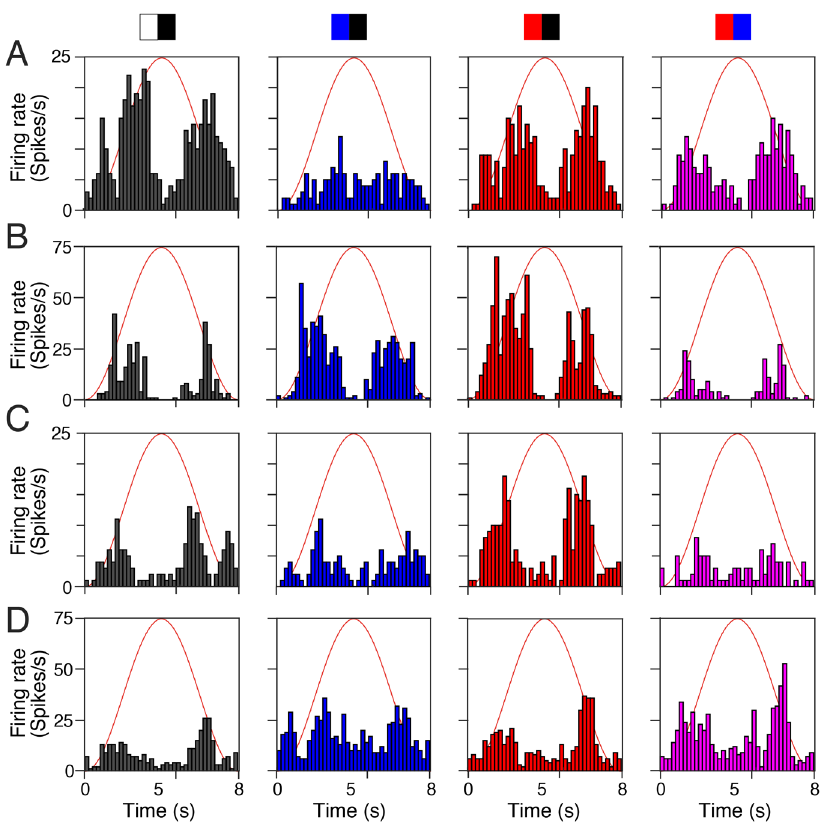
Figure 5. Peri-stimulus time histogram of retinal ganglion cell activity in isolated optic nerves—eyes of Xenopus tadpoles. (A–D) Peri-stimulus time histogram of the average spike discharge (200 ms bin width) over a single image motion cycle at 0.125 Hz (8 s) of the four units with different radiance or color preferences depicted in Fig. 4B as units 1–4; units respond preferentially to high radiance contrast (A) , to blue or red versus black (B) or to red or blue stimulus combinations (C,D) ; black/white and color stripe combinations are indicated by the icons above the top row; red sinusoids represent stimulus cycles. Figure assembled with Affinity Designer (version